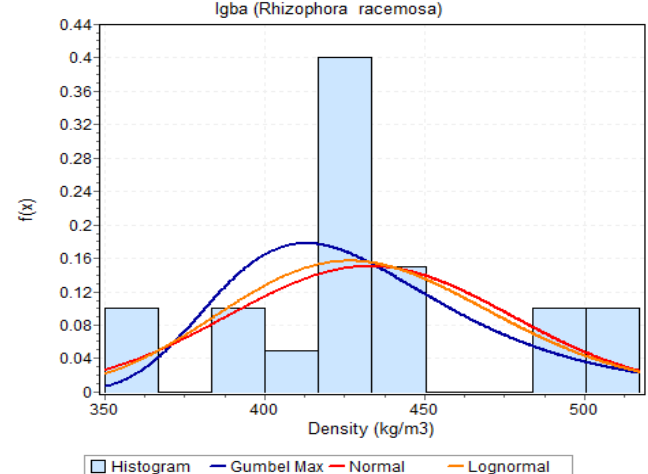
Fig. 5. Probability Density Function Plots for Density of Rhizopora racemosa.